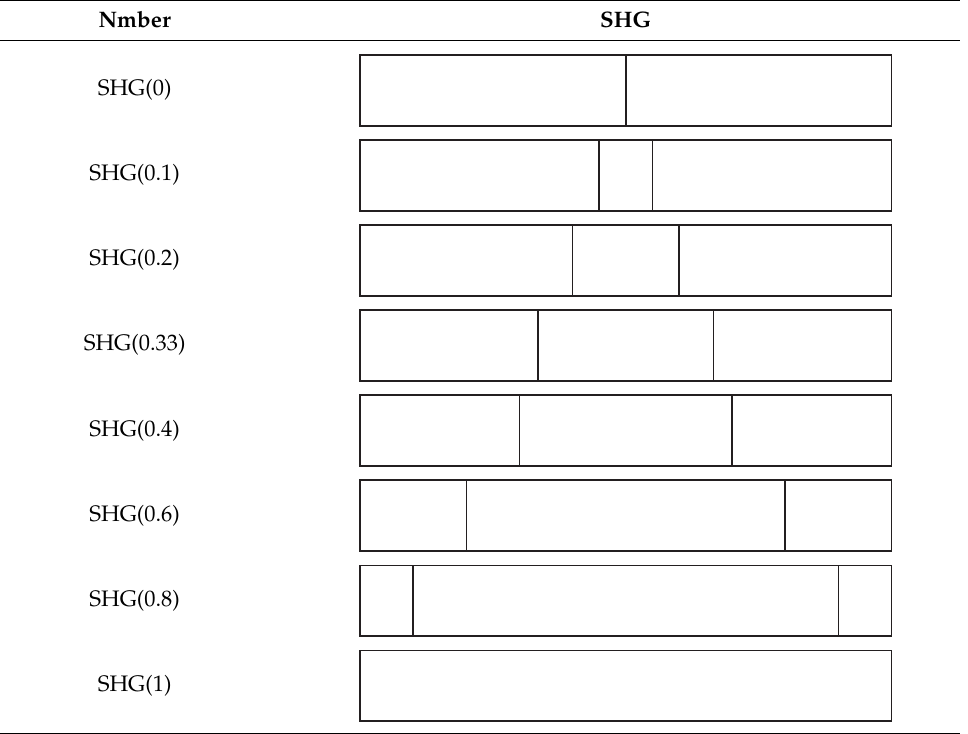
Table 4. Number of SHGs with different transverse bulkheads.